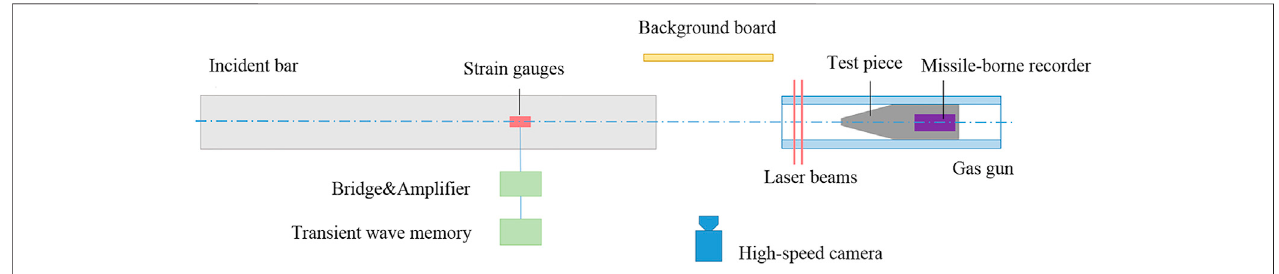
FIGURE 8 | Schematic diagram of the experimental layout. Deformation and Comparison of Test